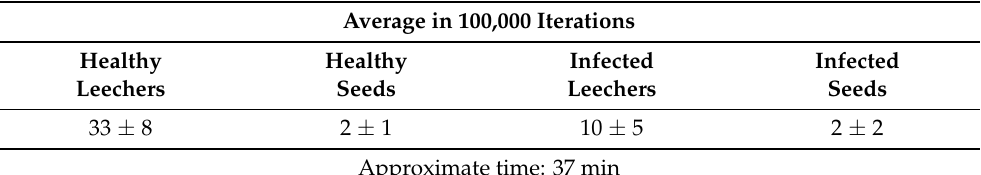
Figure 9. Evaluation in time of one realization of the number of healthy and infected leechers and seeds. Table 5. Average results for each type of peer in the network together with the simulation time of the Markov chain with malicious